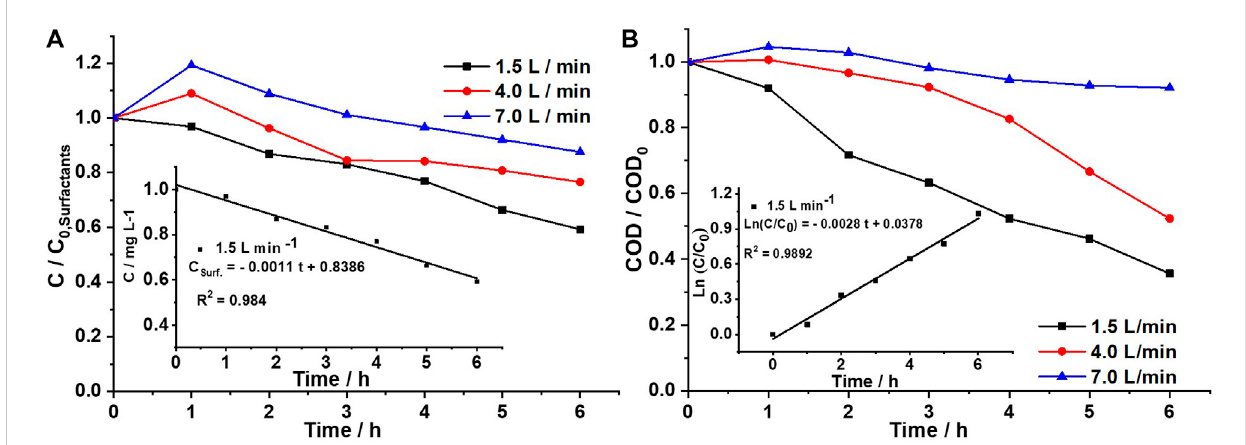
FIGURE 3 Effect of the recirculation fl ow rate on domestic wastewater electroremediation through (A) surfactant concentration and (B) COD, 14 mA cm − 2 , usingaDiaClean ® cell coupledwithBDDasan anodeandSSas acathode.Inset (A) Zero-order kineticsfor surfactant degradation.Inset (B) Pseudo- fi rst- order kinetics for COD removal.